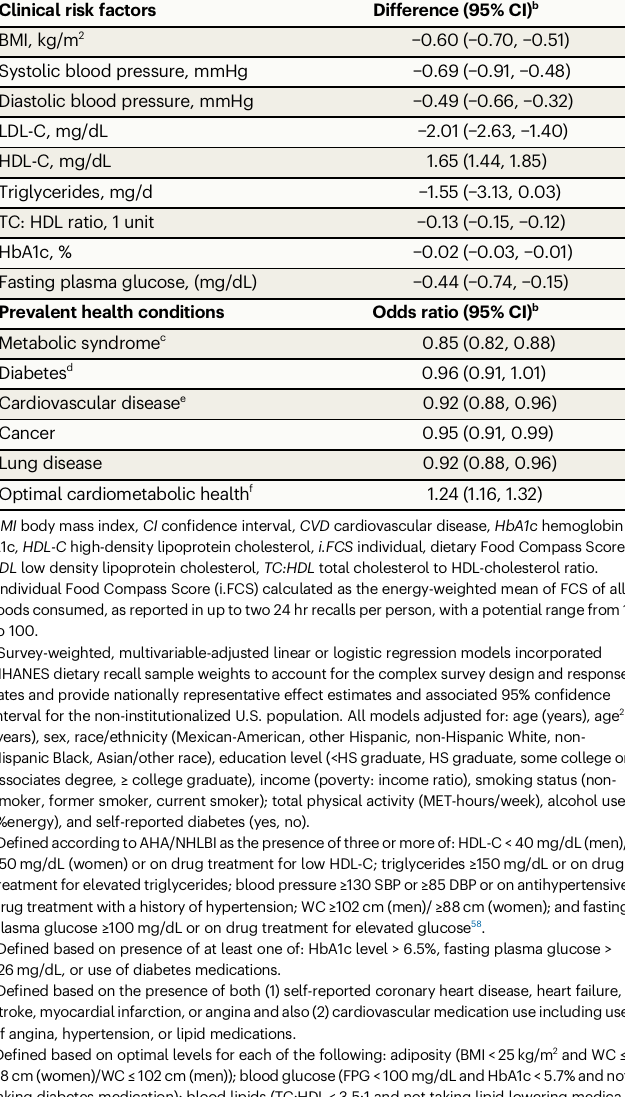
Table 2 | Multivariable-adjusted, cross-sectional associations of the individual Food Compass Score (i.FCS) with major clinical risk factors and prevalent health conditions among U.S. adults, 1999 – 2018 i.FCS, per SD (10.9 points) a